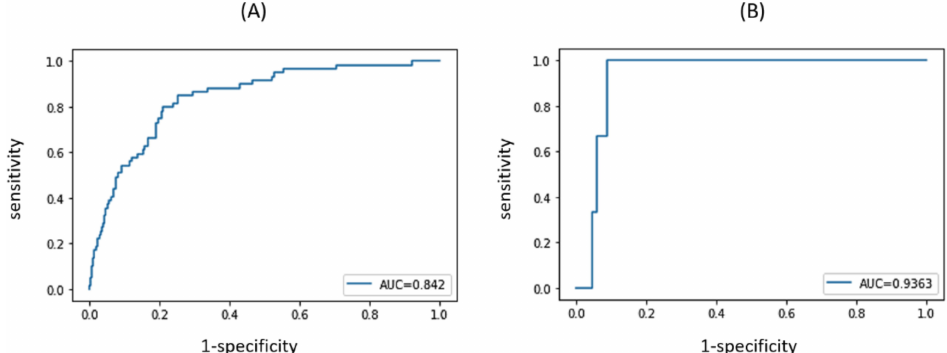
Figure 1. Validation receiver operating characteristic (ROC) curves of the proposed machine learning (ML)-based model on Cohort A and B patients. ( A ): ROC curve for Cohort A. ( B ): ROC curve for Cohort